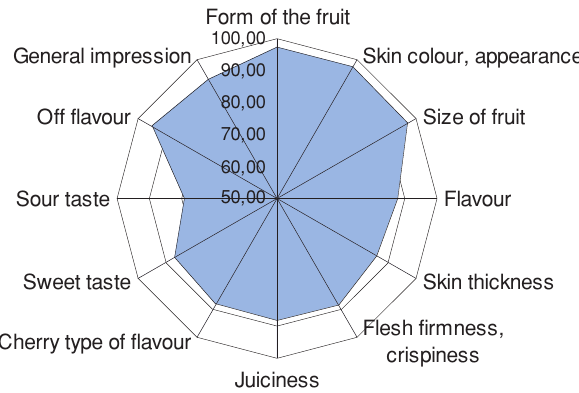
Figure 12. Profile diagram of the sensorial judgement of the variety Germersdorfi